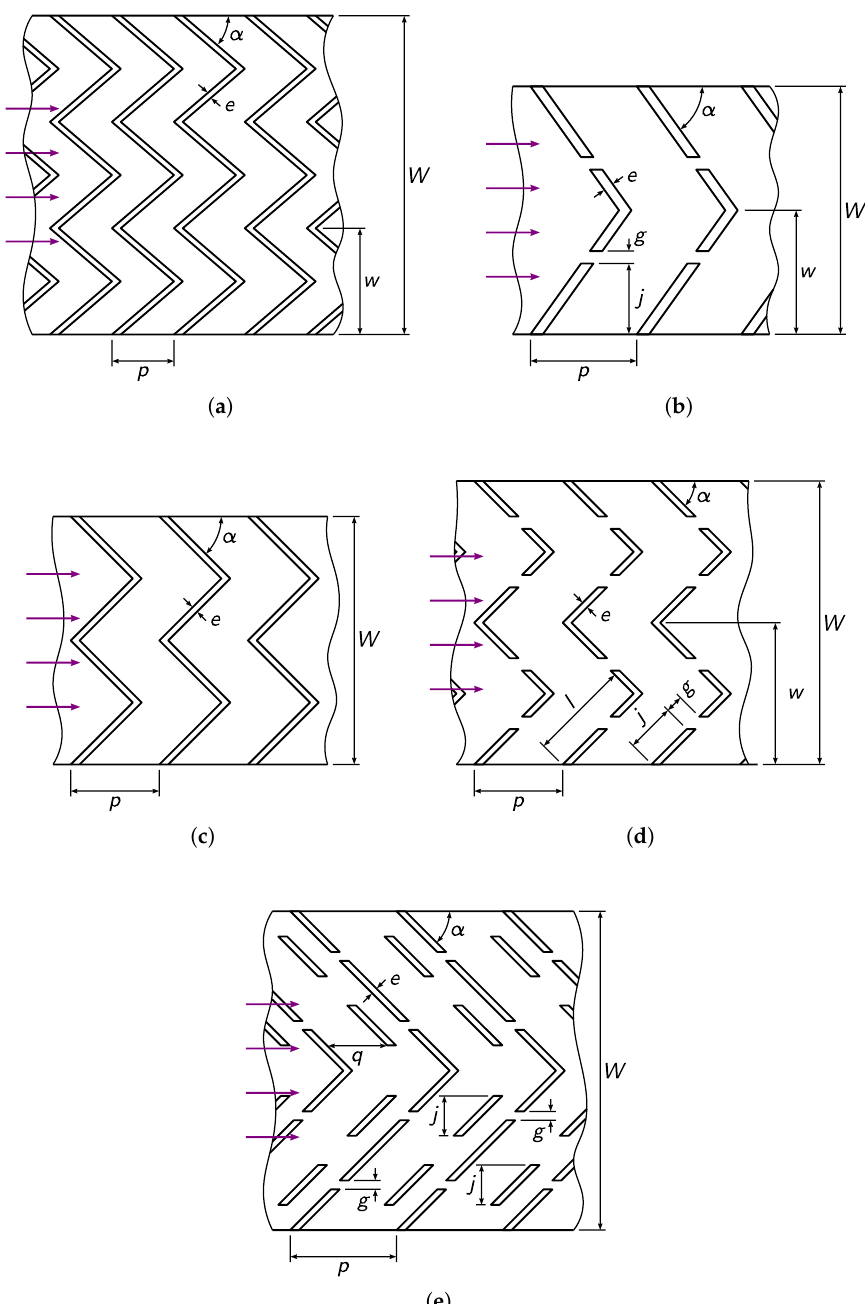
Figure 5. Rib arrangement and roughness parameters of absorber plates with straight